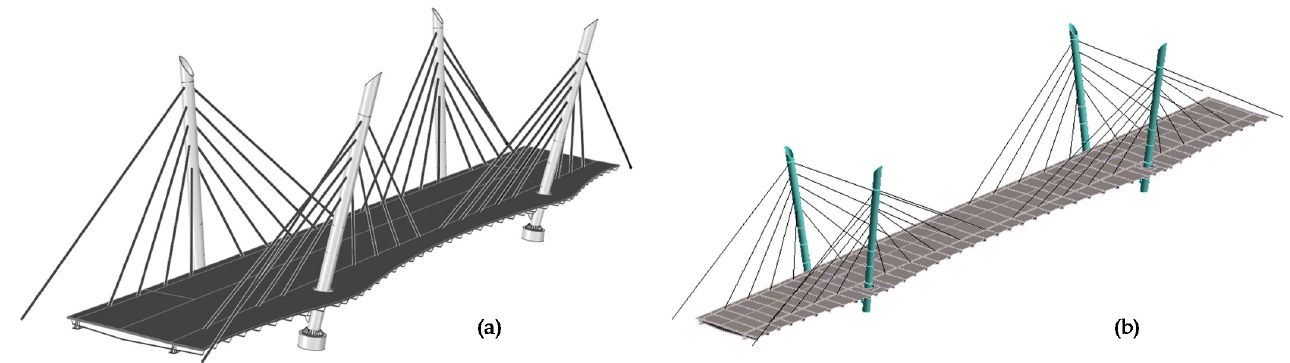
Figure 7. Refined FE model of the bridge: ( a ) solid model, ( b ) shell model.